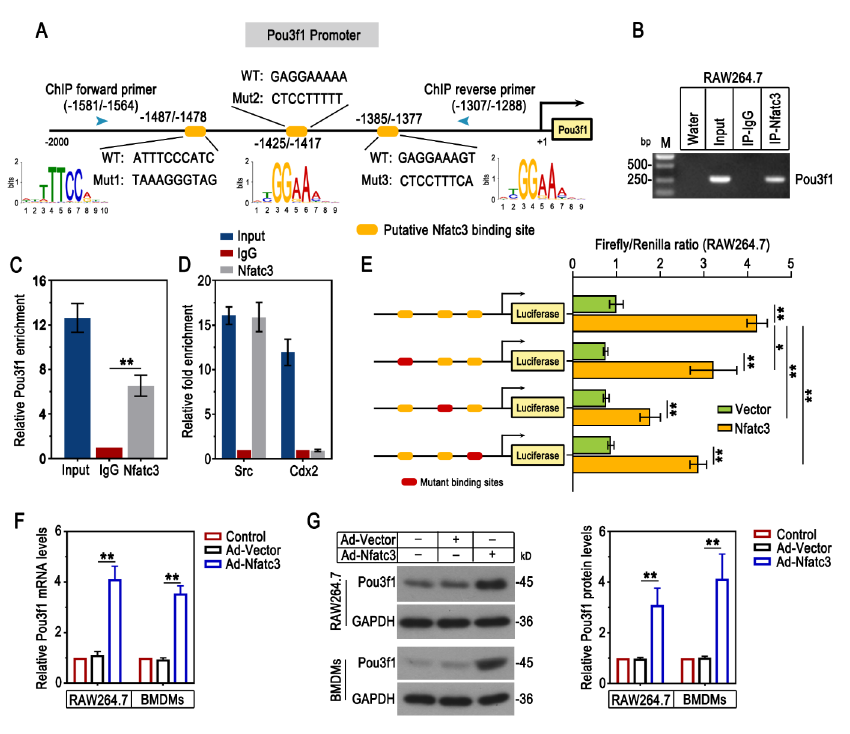
Fig. 2 Pou3f1 was identified as a direct transcriptional target of Nfatc3. (A) The schematic of the potential motifs and binding sites of Nfatc3 in the Pou3f1 promoter region. (B-C) ChIP-PCR and ChIP-qPCR were performed to demonstrate the direct interaction between Nfatc3 and Pou3f1 in RAW264.7 cells. M: Marker. (D) ChIP-qPCR assay demonstrated that Nfatc3 bound to the Src promoter, rather than the Cdx2 promoter in RAW264.7 cells. Src was used as a positive control. Cdx2 was used as a negative control. (E) The relative luciferase activity was measured by luciferase reporter assay in RAW264.7 cells. (F) The mRNA levels of Pou3f1 in RAW264.7 cells and BMDMs were measured by qPCR. (G) Western blot analysis and quantification results for Pou3f1 protein levels in RAW264.7 cells and BMDMs. n = 3. Values were mean ± SD. *, p < 0.05; ** p <